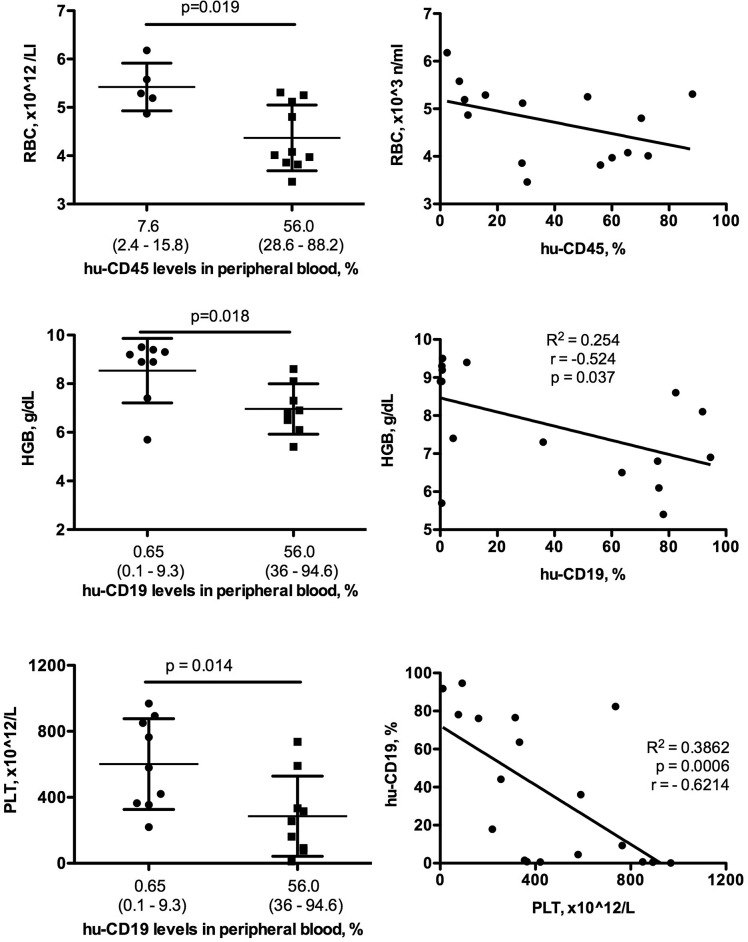
Comparison of hematologic parameters in humanized mice with different levels of peripheral blood repopulation. The high levels of humanization detected by the presence of human cells (CD45+) and, specifically, B cells (CD19+) were associated with decreased red blood cell (RBC) count, hemoglobin concentration and platelets numbers (PLT). A non-parametric Mann Whitney test was used to determine statistical significance between groups of mice with varying levels human cell reconstitution. Individual values, mean and s.d. are shown.